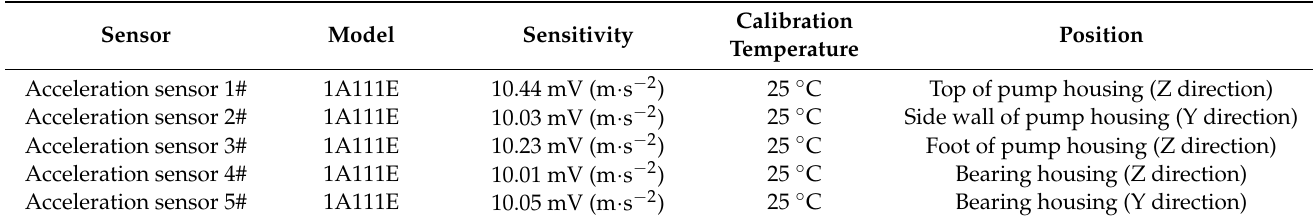
Table 3. Technical information of acceleration sensors.